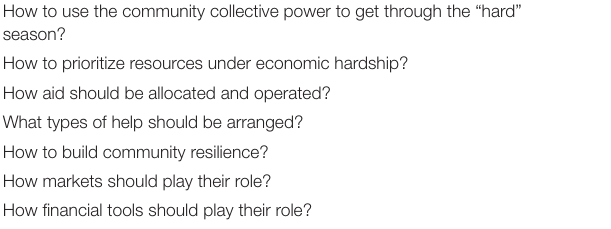
TABLE 2 | Questions arising when tackling food insecurity by domains of the sociotype. INDIVIDUAL How to deal with constant hunger? How to feed people with limited economic resources in the rural and city context? How to keep up food quality and prevent malnutrition with limited economic resources? How to eat previously unacceptable food–culture/religious taboos? RELATIONSHIPS (Family, Community) How to decide to whom to distribute the